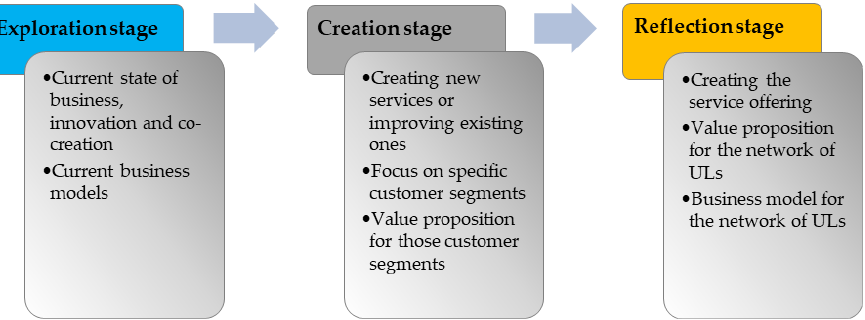
Figure 5. Stages of underground facility service development process.